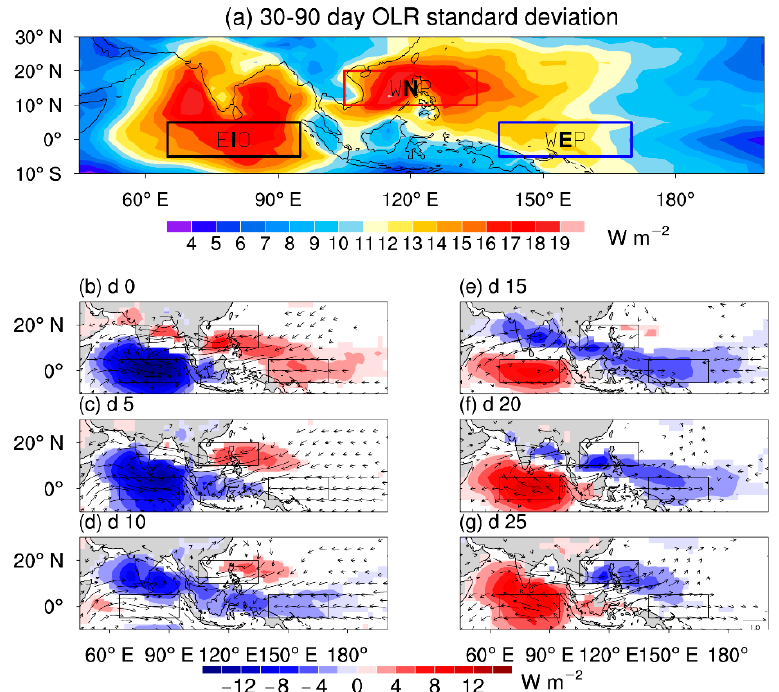
Figure 1. Spatial–temporal evolution characteristics of boreal summer intra-seasonal oscillation (BSISO). ( a ) The BSISO intensity, denoted by the standard deviation of 30–90-day bandpass-filtered outgoing longwave radiation (OLR) during May–September. The black box denotes the equatorial Indian Ocean (EIO, 5 ◦ S–5 ◦ N, 65 ◦ –95 ◦ E), the red box denotes the western North Pacific (WNP, 10 ◦ –20 ◦ N, 105 ◦ –135 ◦ E), and the blue box denotes the western equatorial Pacific (WEP, 5 ◦ S–5 ◦ N, 140 ◦ –170 ◦ E). ( b – g ) Lagged regression map of OLR anomalies (shading; W m − 2 ) and 850-hPa wind anomalies (vector; m / s) from day 0 to day 25 at 5-day intervals onto the EIO OLR anomaly for all summers. A 30–90-day bandpass filter is applied to the OLR before the regression. Anomalies are plotted only when they are significant at the 90% confidence level by Student’s t test.